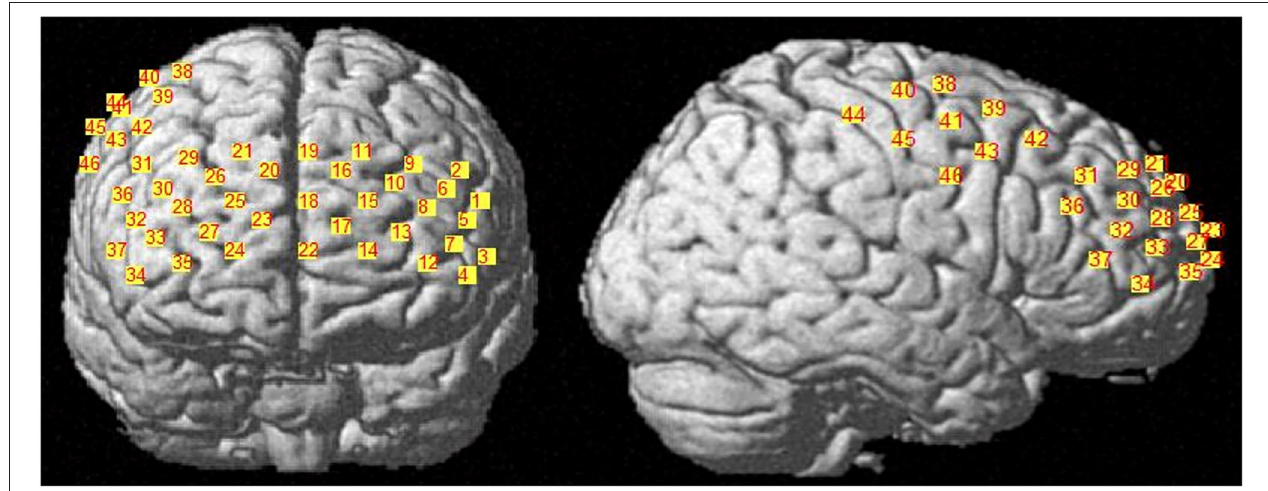
FIGURE 1 | fNIRS 46-channel montage placement. There were 37 channels placed on the prefrontal cortex, and eight channels placed on the right motor cortex.